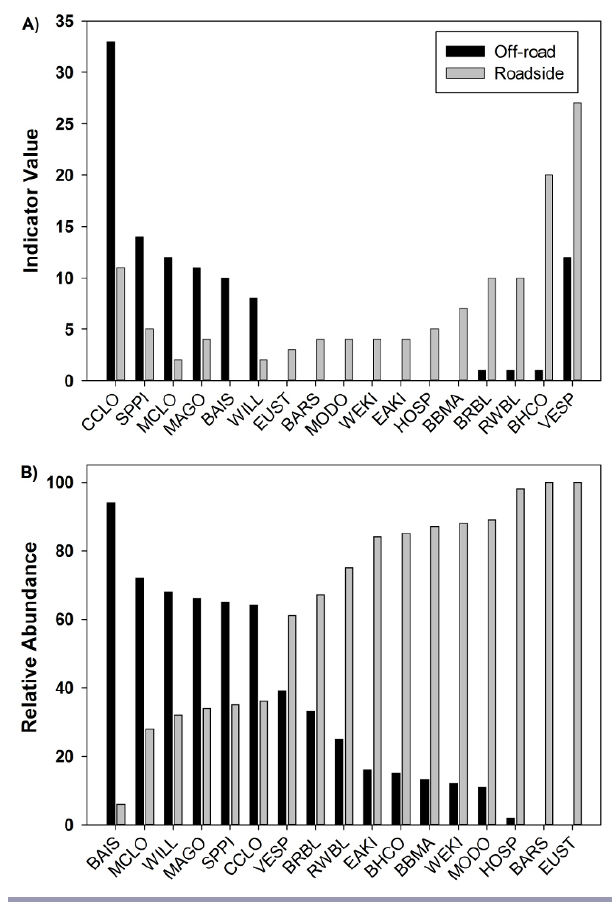
Fig. 3 . Community indicator values (A) and relative abundance (B) for species with significant ( P > 0.05) differences in indicator values, combining both abundance and frequency of occurrence, in roadside ( n = 225 point counts) and off-road ( n = 225 point counts) surveys in the Prairie Ecozone of Alberta. To generate the relative abundance, absolute abundance measures were rescaled so the total of the two abundances (off-road and roadside) were equal to 100. See Table 2 for four-letter species